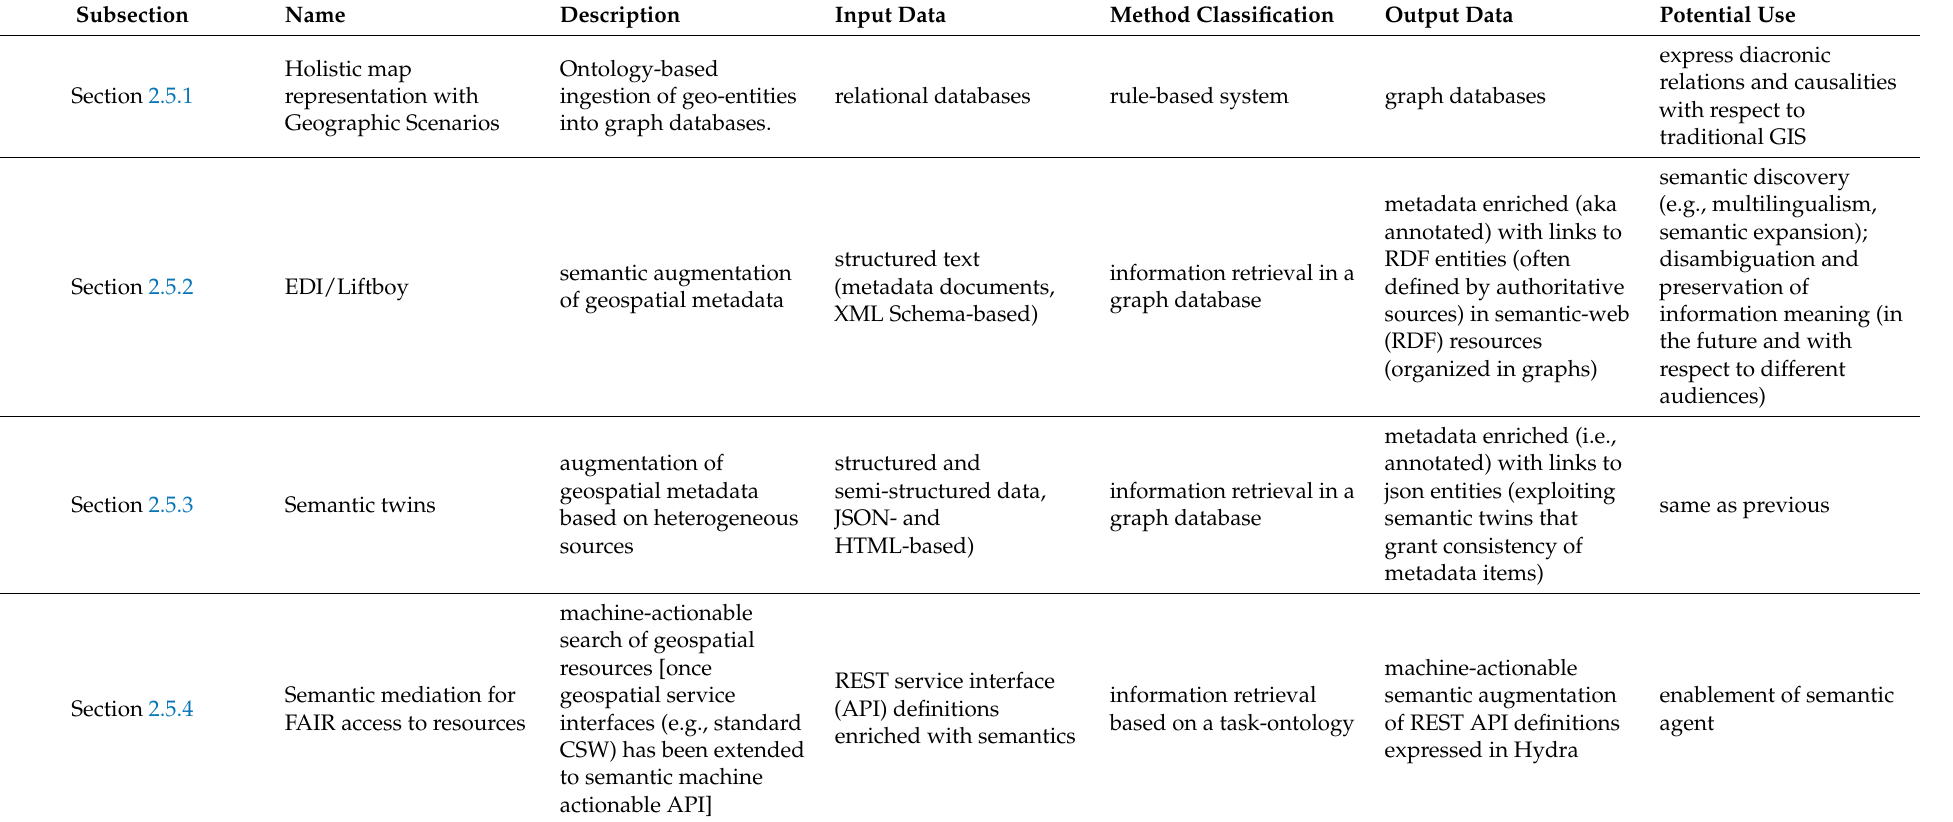
Table 2. Dimensions of case studies (Formal